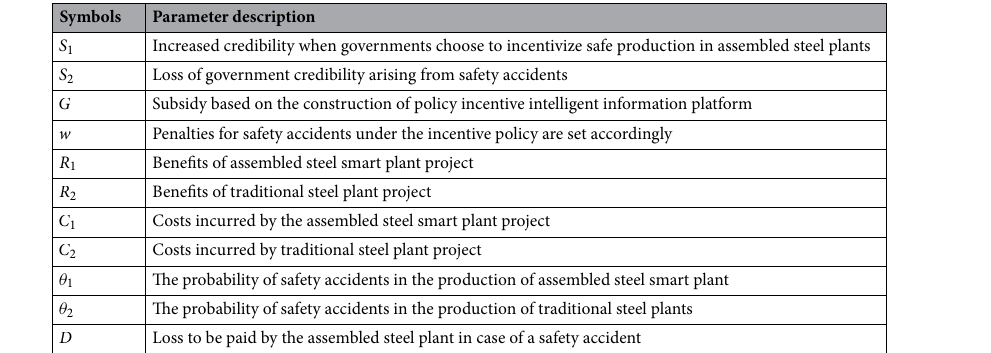
Table 1. Description of model parameters.